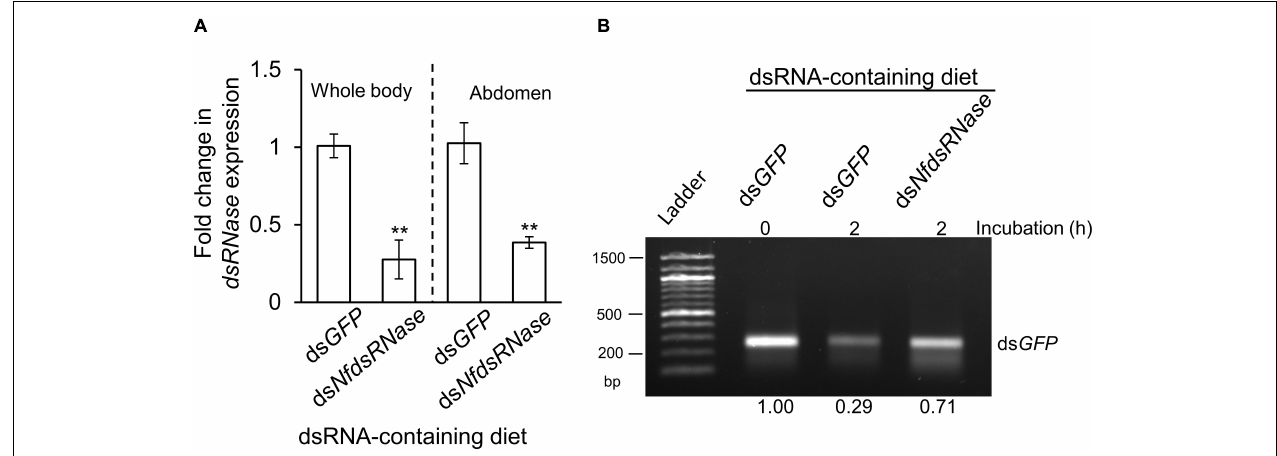
FIGURE 5 | Contribution of NfdsRNase to dsRNA-degrading activity in worker ant midgut. After feeding worker ants with 13% sucrose solution containing 150 ng/ µ L ds GFP or ds NfdsRNase for 5 days, samples (whole body and abdomen) were harvested for gene expression analysis and midgut fluids were collected for ex vivo assays. Feeding on ds NfdsRNase -containing diet significantly reduced the expression of NfdsRNase (A) and dsRNase activity in midgut fluids (B) in worker ants. Gene expression analysis and ex vivo assays were performed as described above. Relative gene expression data were analyzed by the independent samples’ Student’s t test. Statistical significance is marked by ** P < 0.01. dsRNAs incorporated into the 13% sucrose diet were shown above the gel image and duration of ex vivo incubation with ds GFP was also